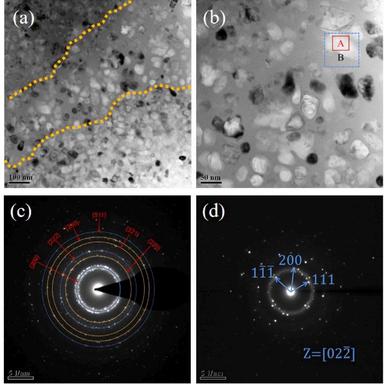
(a) NbC nanograins, (b) high magnification of dispersed NbC nanograins, (c) SAED pattern of region B in (b) (calibrated as NbC phase and Nb3Si phase), (d) SAED pattern of region A in (b) (calibrated as NbC phase).